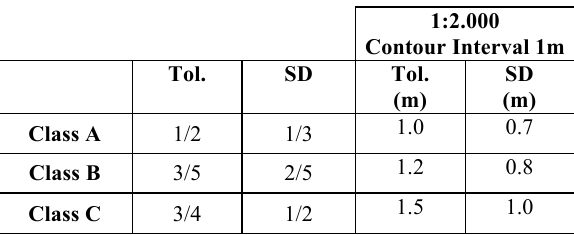
Table 3: PEC altimetric thresholds for 1:5,000